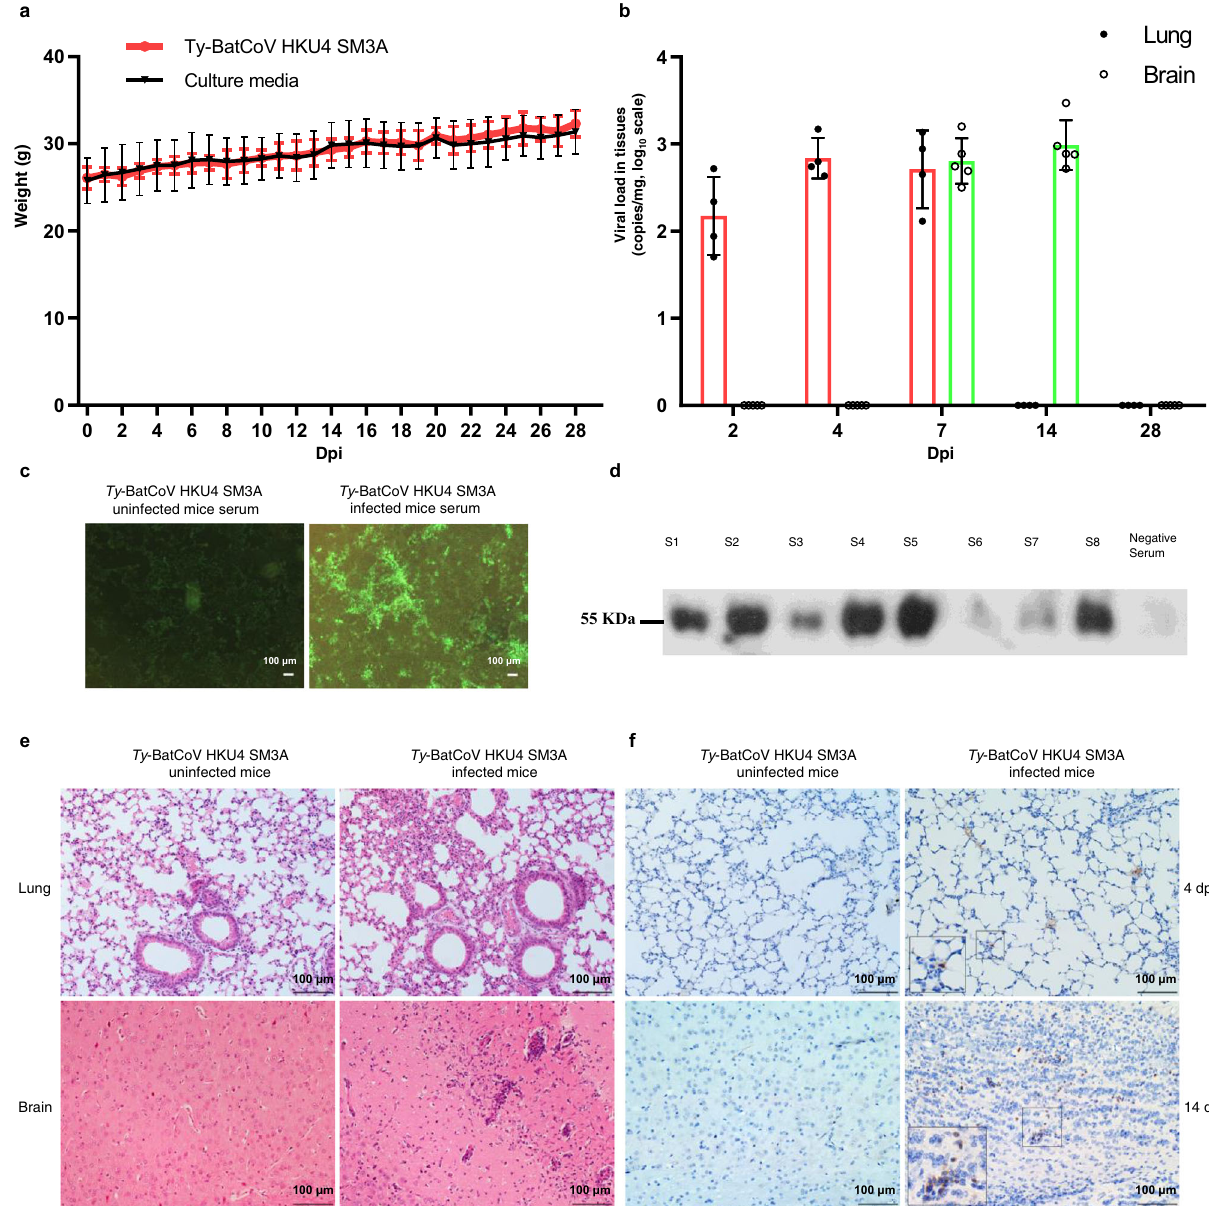
Fig. 4 Transgenic mice with hDPP4 expression are permissive to Ty -BatCoV HKU4 infection. a Weight of transgenic mice after challenge with 1 × 10 6 TCID 50 Ty -BatCoV HKU4 SM3A ( n = 3) or culture media ( n = 3). b RNA levels of Ty -BatCoV HKU4 SM3A detected in lung and brain tissues at 2, 4, 7, 14, and 28 dpi. Data are presented as mean values ± SD, n = 4 (for lung tissues) or 5 (for brain tissues) independent biological replicates at each time point. c IF assay showing antibodies against Ty -BatCoV HKU4 in virus-infected mice serum. Scale bars, 100 μ m. d Western blot assay showing antibodies against viral N antigen in virus-infected mice serum. Representative H&E ( e ) and IHC ( f ) stained tissue sections from lungs at 4 dpi and brains at 14 dpi. Scale bars, 100 μ m. Images are representative of three independent experiments. Uncropped blots in Source Data are provided as Source Data fi